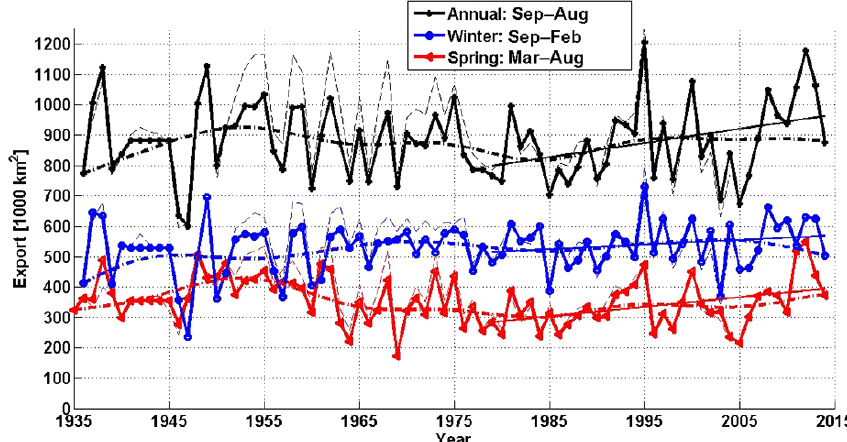
Figure 5. Southward ice area export in Fram Strait. Ice export from 1935 to 2003 is based on the relationship between observed mean sea level pressure and observed ice export by SAR, and ice export from 2004 to 2014 is solely the observations by SAR. Annual values (black) are averaged for 1 September through 31 August. Winter export is 1 September–28 February (blue) and Spring is 1 March–31 August (red). Values are plotted half way through the respective period. Smoothed time series are included produced by filtering with a 20-year-cutoff eighth-order Butterworth filter (thick dash-dotted lines), and linear trends are plotted onwards from 1979. The long-term (1935–2014) trends are not included because they are not significantly different from zero. The effect of using a time-varying seasonal sea ice concentration based on Walsh et al. (2015) is shown using thin dashed